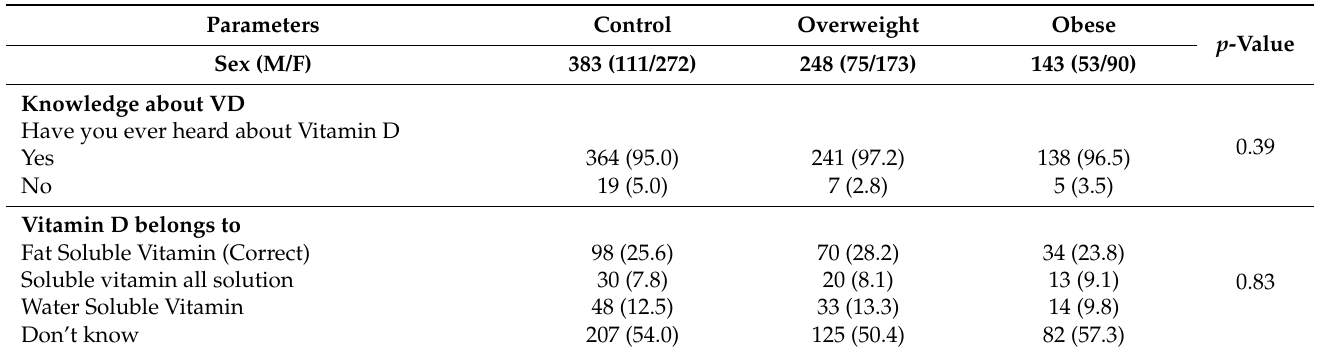
Table 2. Vitamin D knowledge, behavior, and attitude on basis of BMI Status information of the